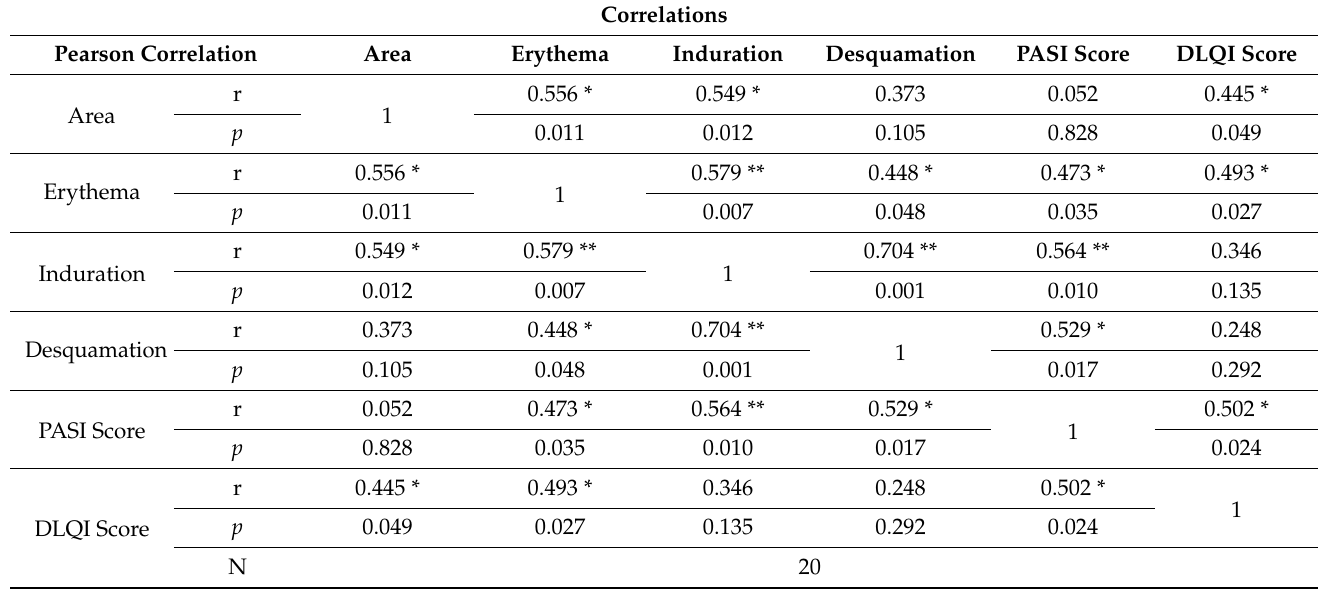
Table 5. Pearson correlation of the difference between research